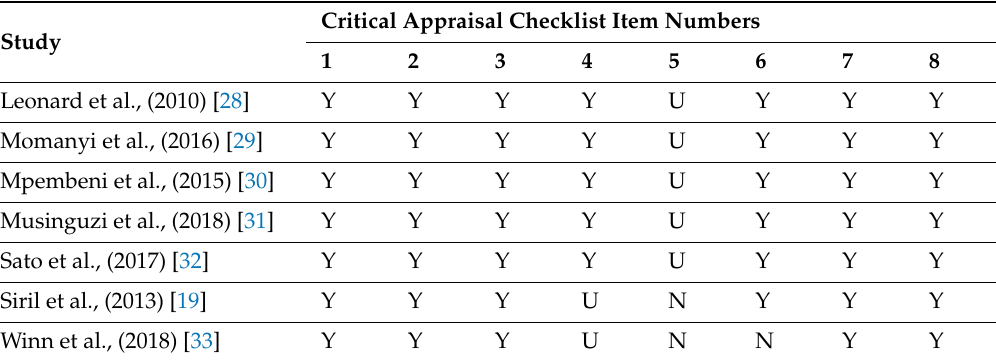
Table 4. Methodological quality of quantitative studies included.